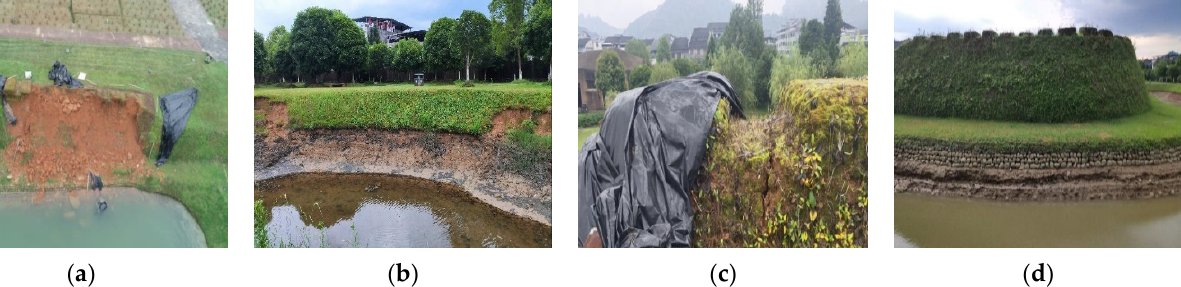
Figure 3. Damage status. ( a ) Wall surface stripping; ( b ) bottom erosion; ( c ) longitudinal cracking of wall; ( d ) complete part of trench.